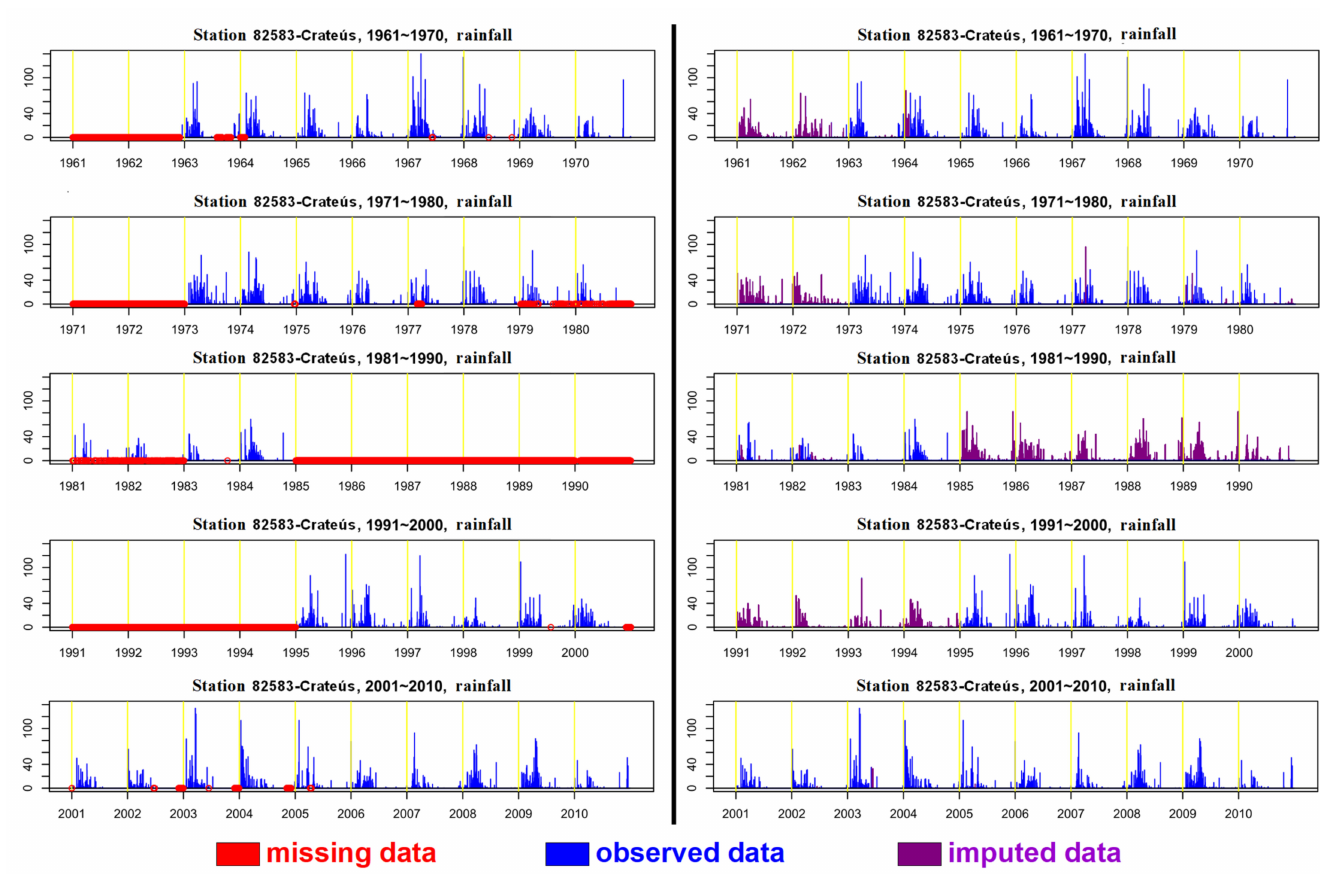
Figure 10. The original series from a station for every 10 years from 1961 to 2010, showing the gaps ( left ) and after these gaps had been filled ( right ). The code and name of the station, the subperiods and the variables are indicated in the graph. Originally missing data are indicated by the red colour, while blue implies observed data and violet indicates imputed